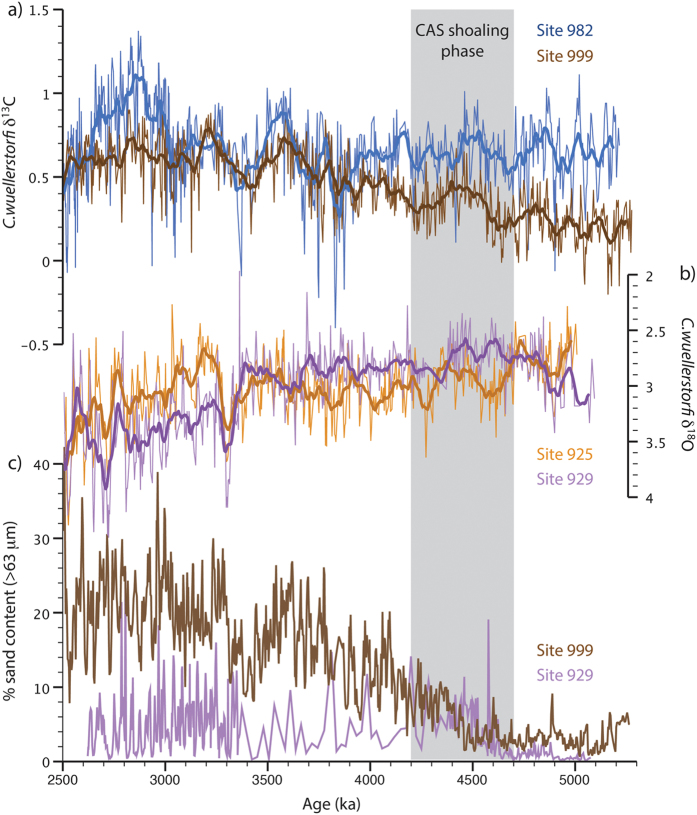
The main evidence for NADW changes in response to the early Pliocene shoaling of the CAS.(a) δ13C (‰ vs Vienna Pee Dee Belemnite) time series from Caribbean Site 999 and North Atlantic Site 982. The increasing δ13C values at Site 999 are interpreted to reflect a progressive increase in AMOC3; (b) δ18O timeseries (‰ vs Vienna Pee Dee Belemnite) from western equatorial Atlantic Sites 925 and 929. The reversal of δ18O gradients after ~4.7 Ma are interpreted to reflect an increase in temperature and salinity due to enhanced northward heat and salt transport25; (c) % sand content timeseries for Sites 999 and 9293. The increases in average and variability of % sand are interpreted to reflect enhanced carbonate preservation in response to an increase in dominance of low-corrosive NADW at both sites3. Bold lines represent 50 kyr running averages. References for isotopic data are given in Table 1.